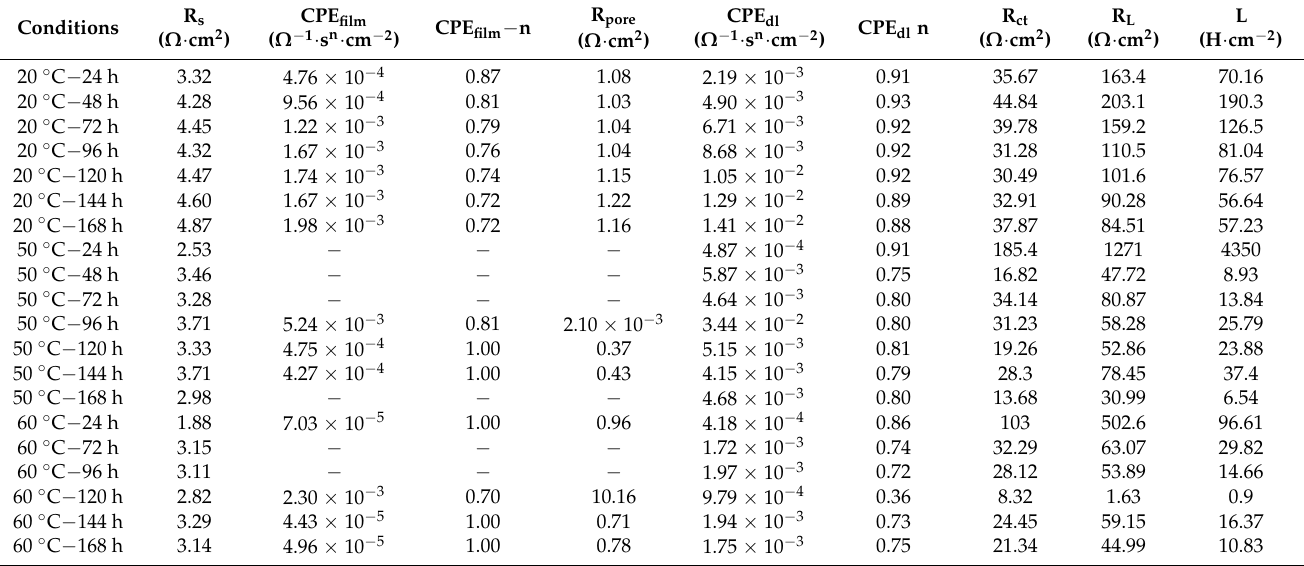
Figure 8. Equivalent circuits used for modeling the EIS results in Figure 8. ( a ) No film, ( b ) With film. Table 5. Values of the elements of the equivalent circuit in Figure 8 to fit the impedance spectra of Figure 7.